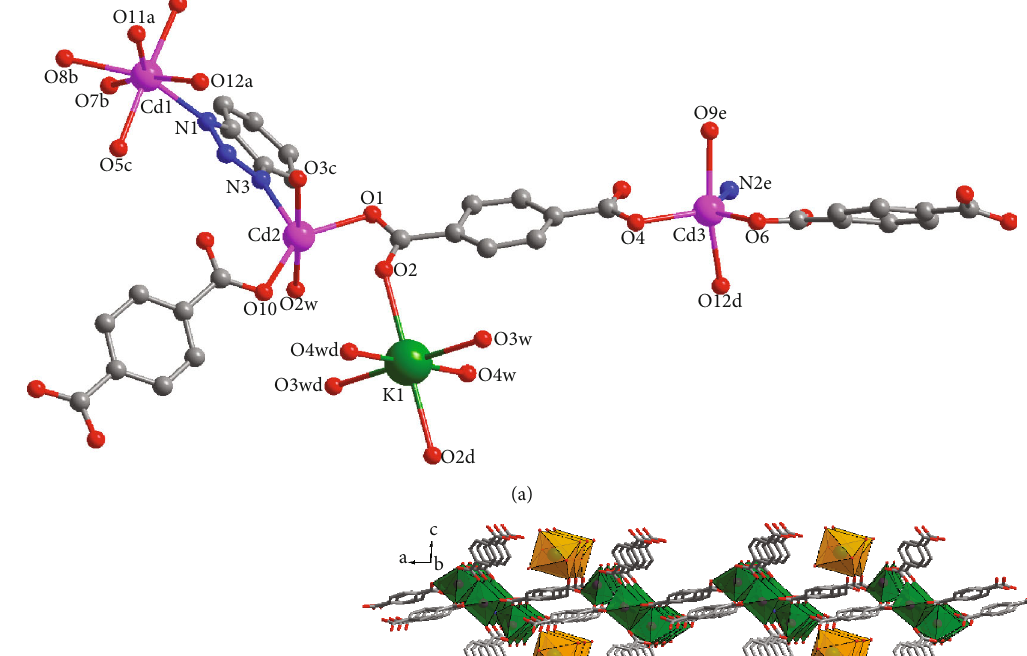
Figure 2: (a) View of the environments of Cd(II) ions in 1 . (b) Trinuclear [Cd 3D framework of 1 . (d) Schematic representation of the 6-connected pcu topological network for 1